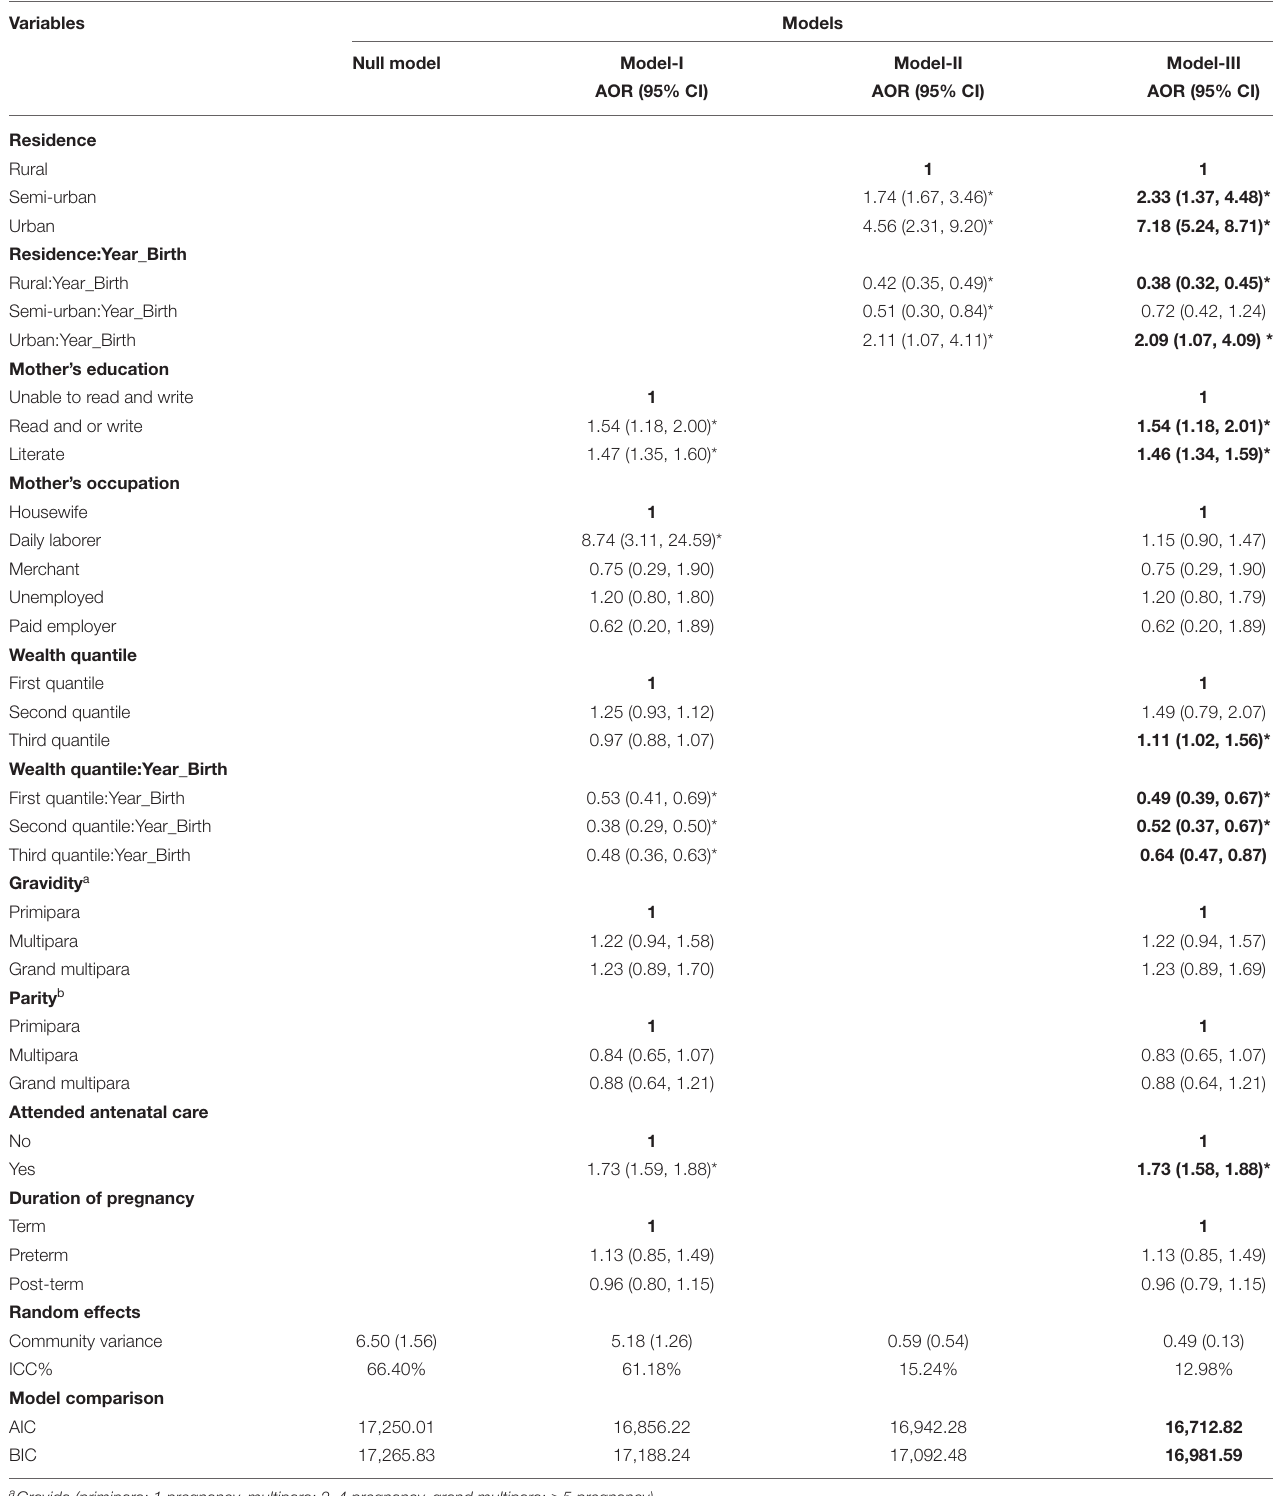
TABLE 4 | Multivariable multilevel binary logistic regression for institutional delivery among mothers of reproductive age (15–49 years) at Kersa HDSS,